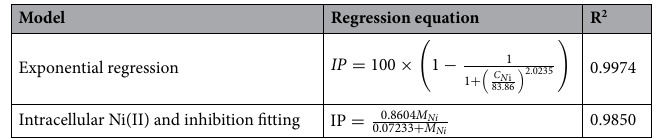
Table 2. Regression analysis of Ni(II) inhibition equations.